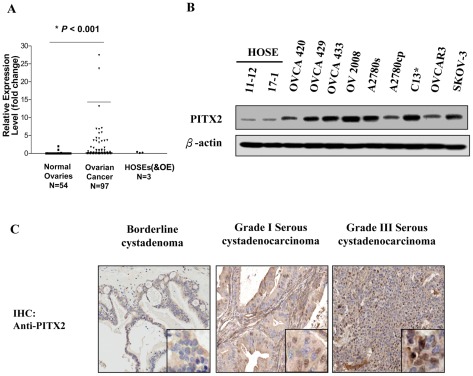

PITX2 is upregulated in ovarian cancer samples and cell lines.(A) Quantitative RT-PCR analysis was performed in normal ovaries (n = 54) and ovarian cancer samples (n = 97) using PITX2 specific primer. 18S and TATA-box binding protein (TBP) were used as the internal loading controls. *P<0.001. (B) Western blot analysis using anti-PITX2 antibody to evaluate the expression level of PITX2 (isoforms A, B and C)) (35 kDa) in ovarian cancer cell lines (n = 9) and HOSE cell lines (n = 2). β-actin was used as a loading control. (C) Immunohistochemical analysis of PITX2 expression (nuclear staining) in borderline cystadenoma and high-grade (3) serous cystadenocarcinoma on an ovarian cancer tissue array (OVC1021). Magnification: 20×.